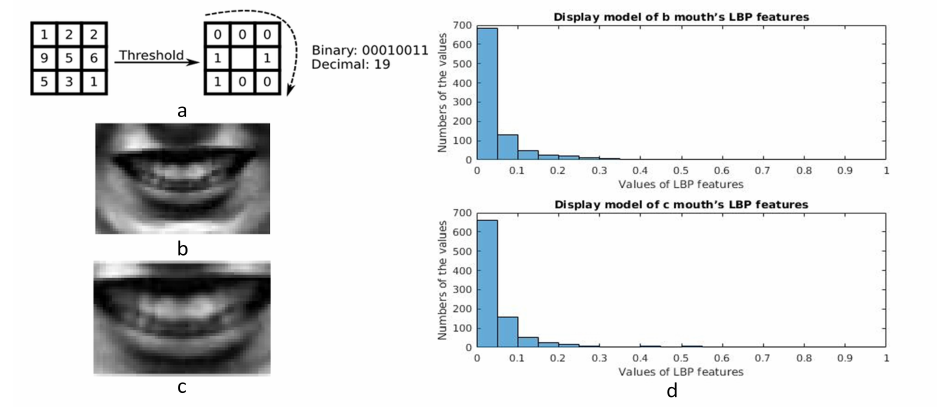
Figure 4. ( a ) Calculation progress of the original Local Binary Patterns (LBP) value; ( b ) Mouth area with pixels of 40 × 60; ( c ) Mouth area with the former pixels of 28 × 42, the real pixels are enlarged from the former image; ( d ) Display models of ( b , c ) mouth.